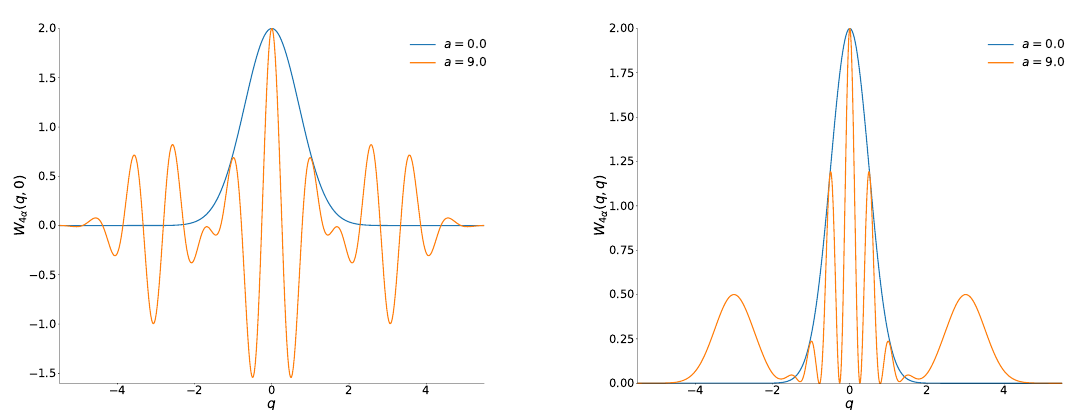
Figure 7. The sections of function W 4 α ( q , p ) for α = | α | exp ( i π /4 ) . Left : W 4 α ( q ,0 ) . Right : W 4 α ( q , q ) .